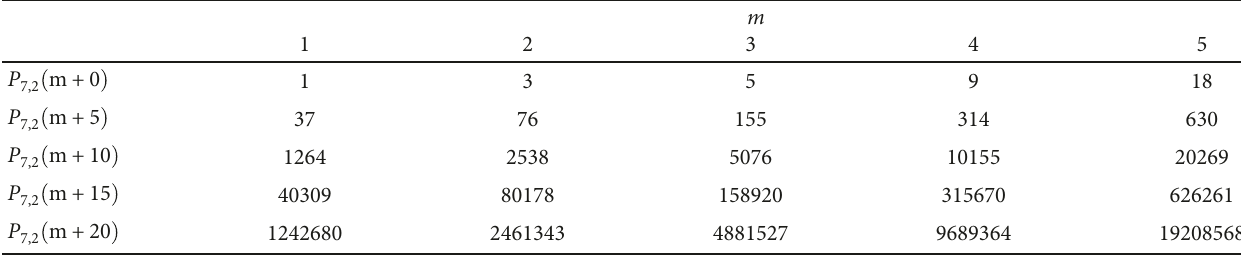
n sequence for n ≤ 25 . 7,2